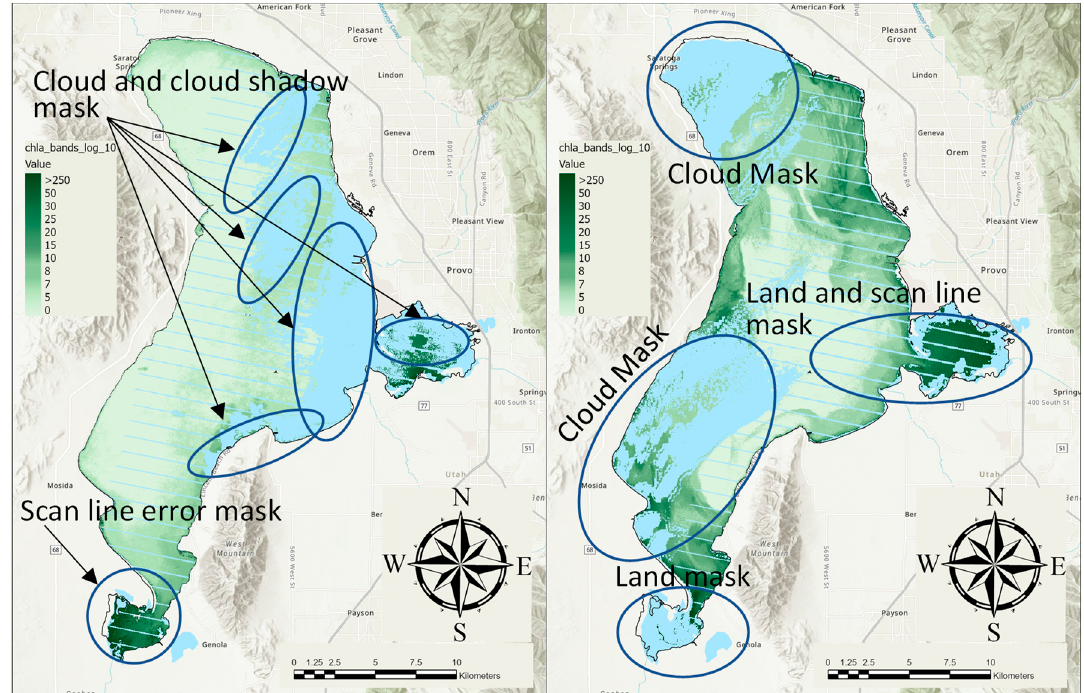
Figure 3. An example showing the different types of masks with chl-a concentration images from 11 April 2012 and 1 August 2012 for the left and right panels, respectively. The background map shows the approximate area of Utah Lake in blue, masked pixels are transparent, and pixels not masked are pale yellow to dark green based on chl-a concentrations. The left panel shows areas that are masked to eliminate cloud-contaminated pixels and pixels that are impacted by scan-line errors. The right panel shows pixels masked by whether or not the pixel contains land. On this date, the lake level was very low and both Provo Bay and Goshen Bay had significant exposed shoreline.